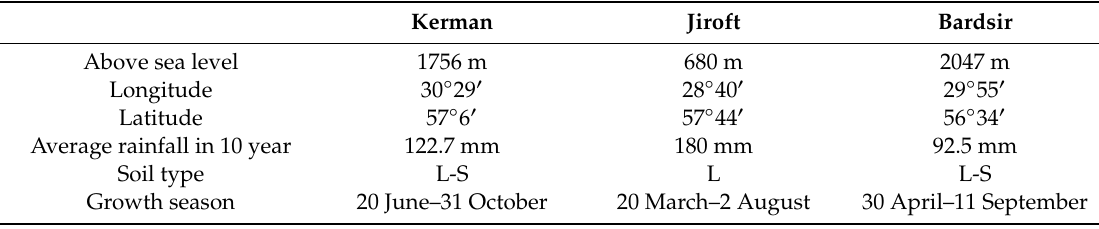
Table 1. Geographical characteristics of the study sites in di ff erent regions. Kerman Jiroft